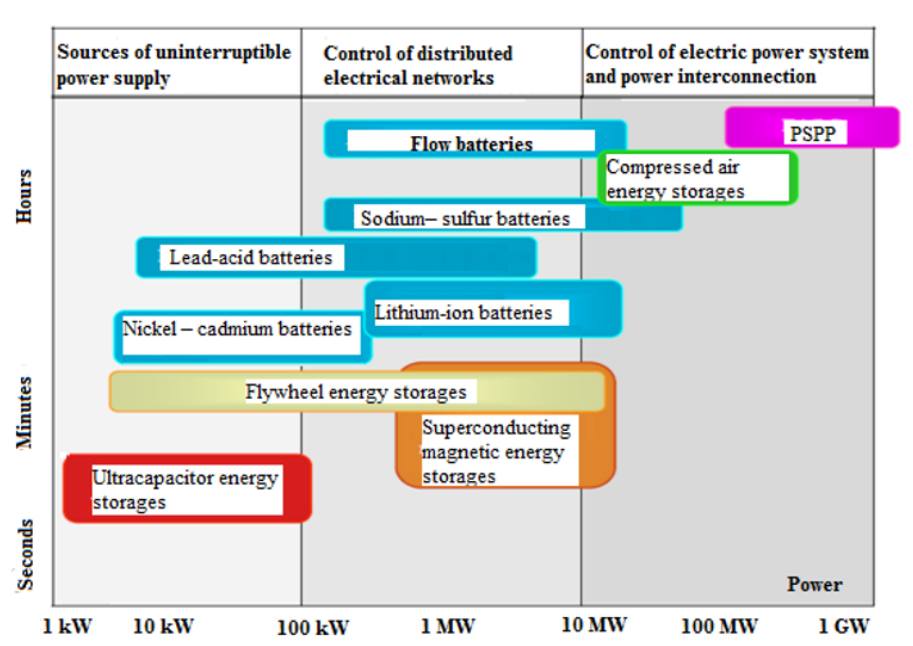
Fig. 2. Fields of application of different types of energy storage